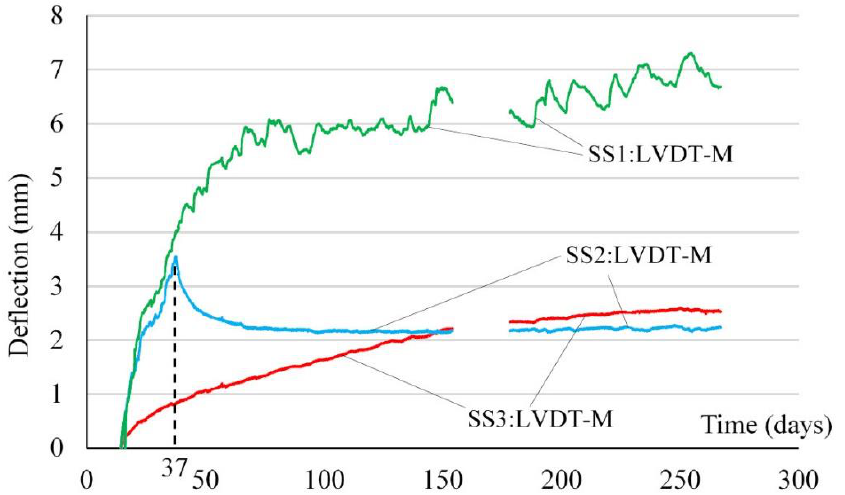
Figure 5. Mid-span deflections measured for simply-supported samples (LVDT-M = mid-span deflection) [53].